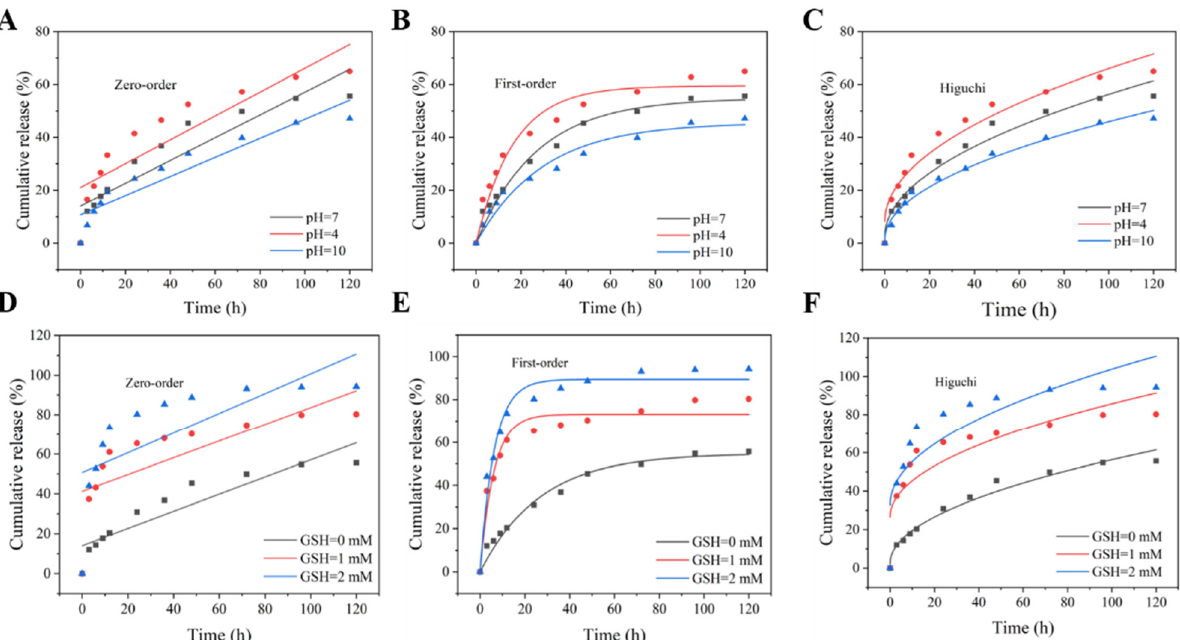
Figure A2. Kinetics fitting models of Pro@BMMs-SS-Py/ β -CD NPs with different ( A – C ) pH and ( D – F ) GSH values. Table A1. Release parameters of Pro@BMMs-SS-Py/ β -CD NPs at different pH values. Table A2. Release parameters of Pro@BMMs-SS-Py/ β -CD NPs with different GSH concentrations.